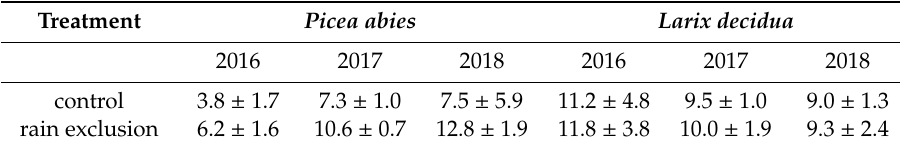
Table 1. Maximum sap flow density ( Q Smax ; g m − 2 s − 1 ) of Picea abies and Larix decidua saplings in control and rain exclusion plots obtained during the study periods 2016, 2017, and 2018. Data are medians ± half total range of three saplings per treatment. No significant e ff ects of rain exclusion were